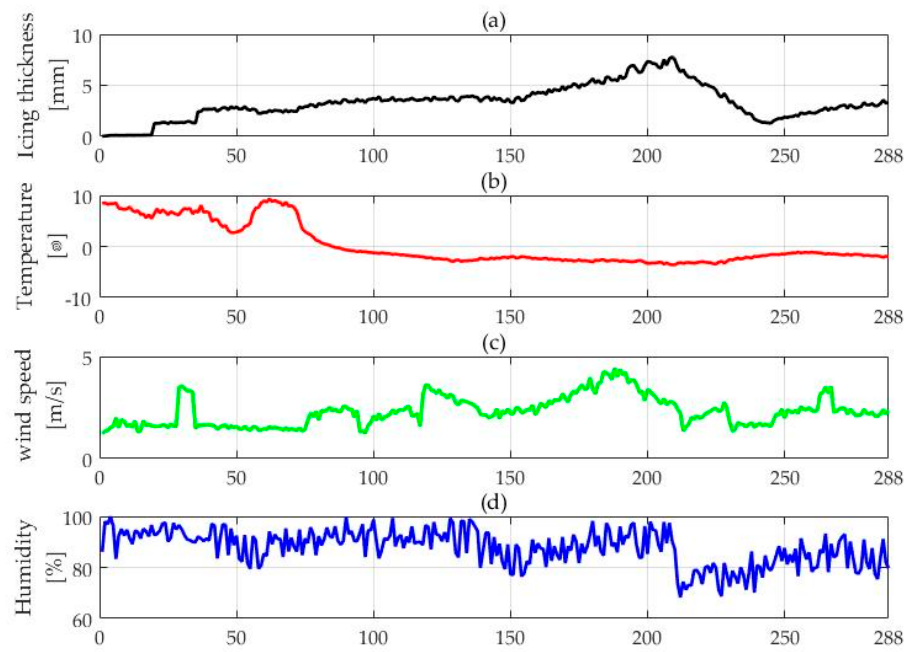
Figure 4. Original data chart of icing thickness, temperature, wind speed and humidity. Note: ( a ) represents the original data of icing thickness; ( b ) represents the original data of temperature; ( c ) represents the original data of wind speed; and ( d ) represents the original data of humidity.